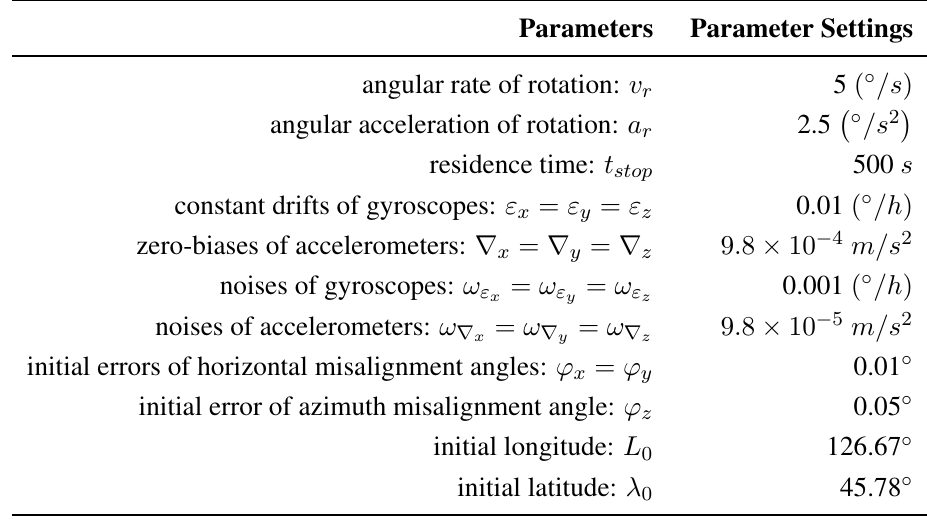
Table 1. Simulation